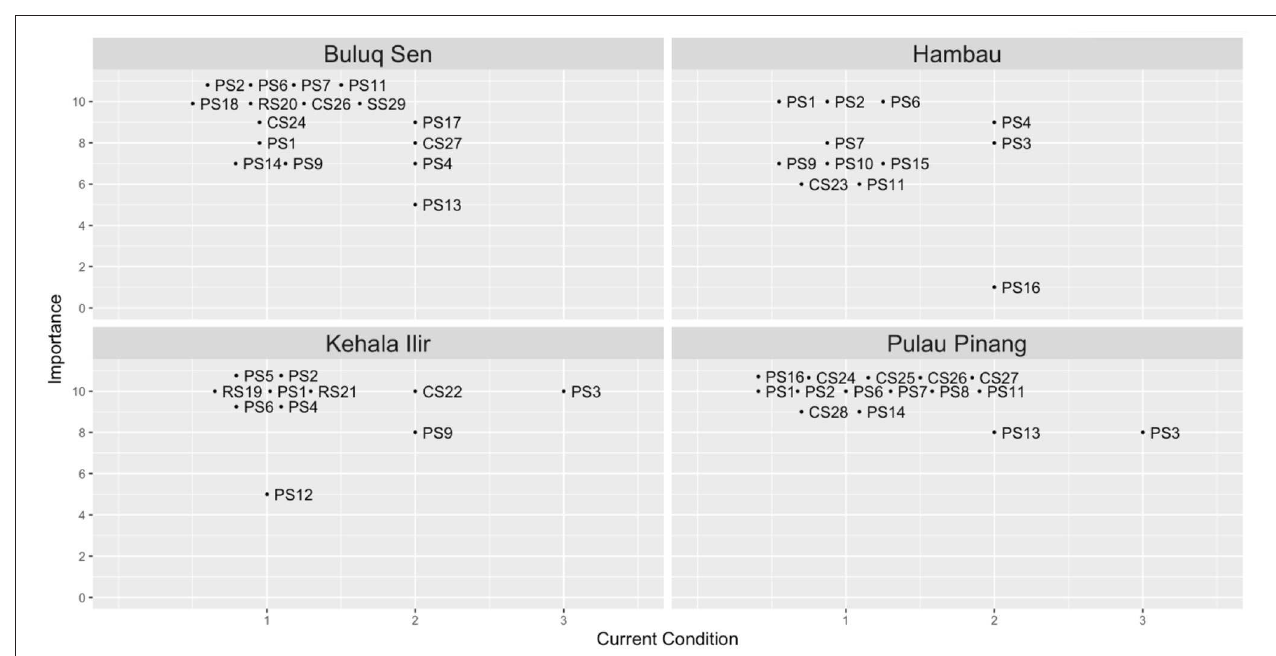
FIGURE 4 | Distribution of the importance-and current condition of the Ecosystem Services by the community in each village.